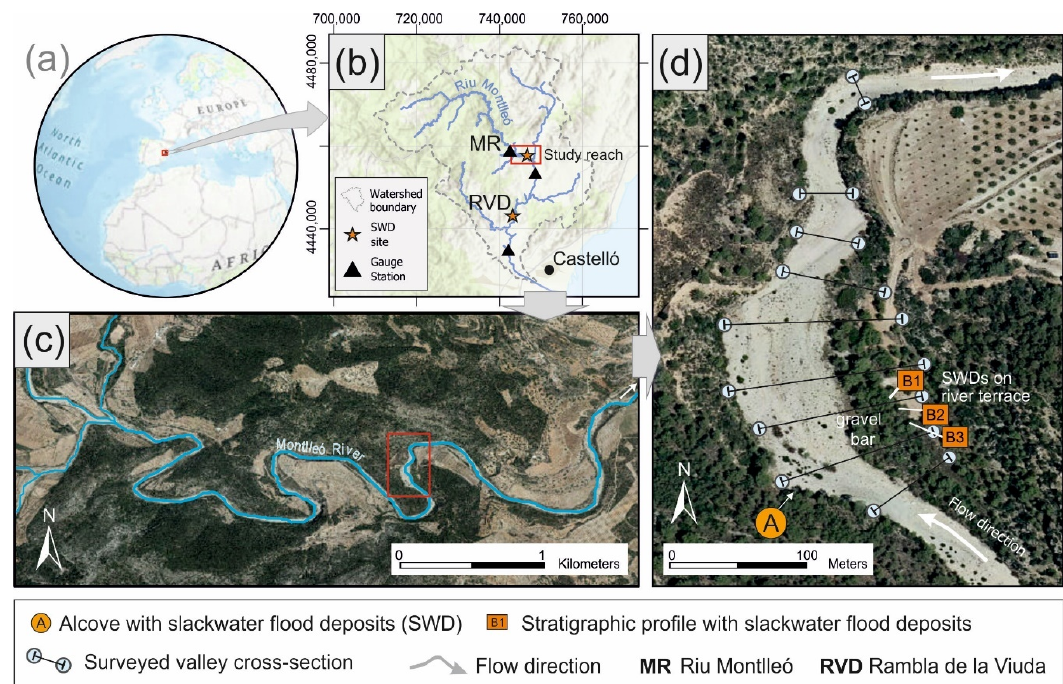
Figure 1. ( a ) The Montlleó River in the Iberian Peninsula. ( b ): Location of the Montlleó River in the Rambla de la Viuda River (RVD) catchment in eastern Spain. ( c ) Aerial photo of the Montlleó stream channel constrained laterally by bedrock, and location of the reach preserving slackwater flood deposits (SWD). ( d ) Study reach illustrating the location of slackwater flood deposits overlying a stream terrace (square B#) and in a rock alcove (circled A), and surveyed cross sections used in the hydraulic model.